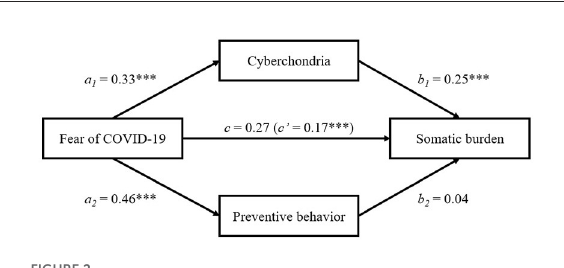
FIGURE2 Mediation effects of cyberchondria and preventive behavior in the relationship between COVID-19 fear and somatic burden.